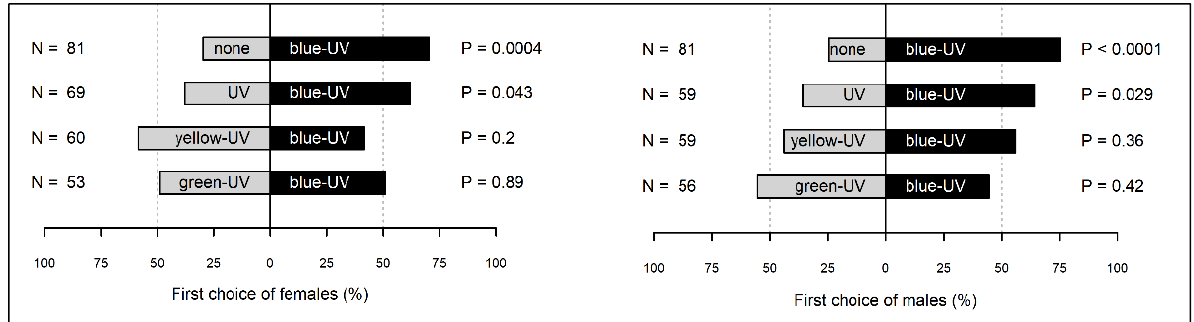
Figure 2. First choice (%) of Halyomorpha halys females and males in a two-choice experimental setup. One choice (black bar) consisted of blue-UV lamp. The other choice (grey bar) consisted of the control stimulus (no light and no grid), or in a single lamp emitting UV, yellow-UV or green-UV light. For each comparison, H. halys preference was analysed by means of binomial GLM.